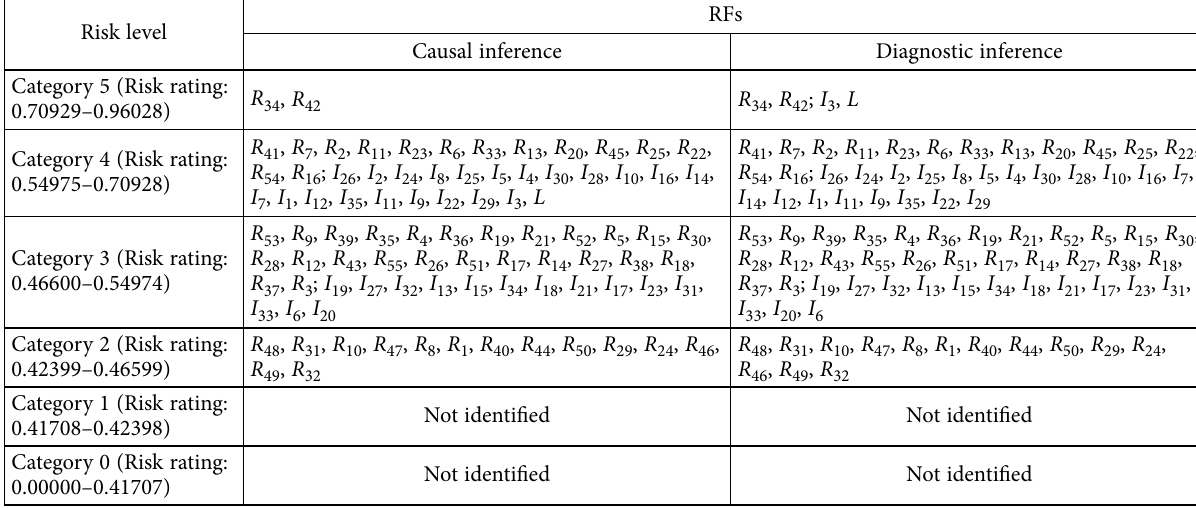
Table 5. Risk categorization for the Ankara-Istanbul high-speed railway project based on FBBN-based RA model Risk